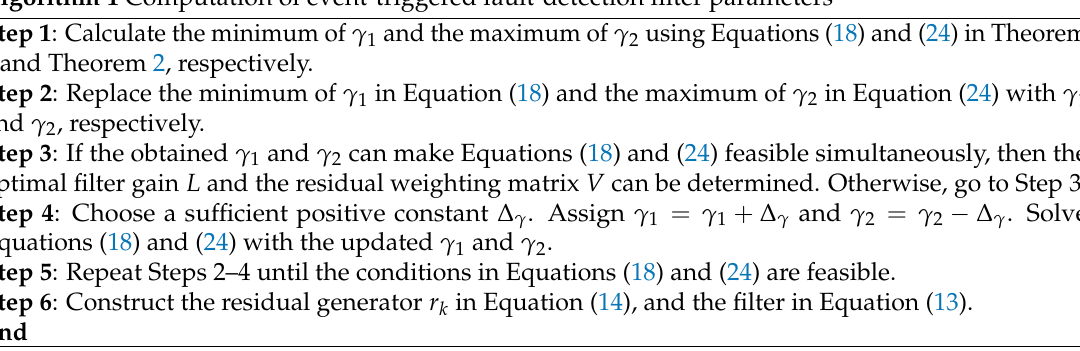
Algorithm 1 Computation of event-triggered fault-detection filter parameters